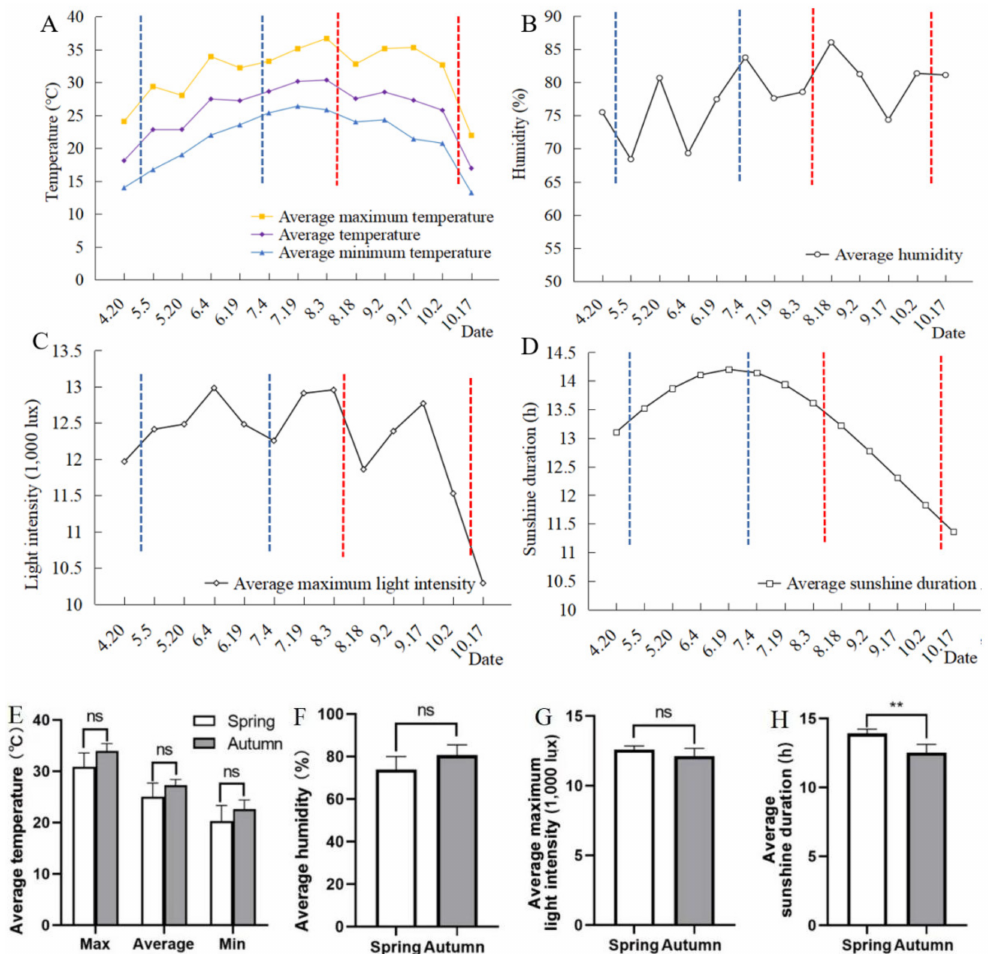
Figure 6. Average meteorological factor every 15 days of spring and autumn sowing. ( A – D ) Trend chart of average meteorological factors every 15 days for spring and autumn sowing: ( A ) temperature; ( B ) humidity; ( C ) light intensity; ( D ) sunshine duration; the insect rearing duration in the V6 stage to inoculate eggs in spring sowing is between the blue dotted lines, and the insect rearing duration in autumn sowing is between the red dotted lines. ( E – H ) Comparison of meteorological factors between spring sowing and autumn sowing: ( E ) temperature; ( F ) humidity; ( G ) light intensity; ( H ) sunshine duration; the meteorological factors of the two sowing seasons in spring and autumn were compared by t -test; ns: not significant; ** represents significance at 0.01 probability